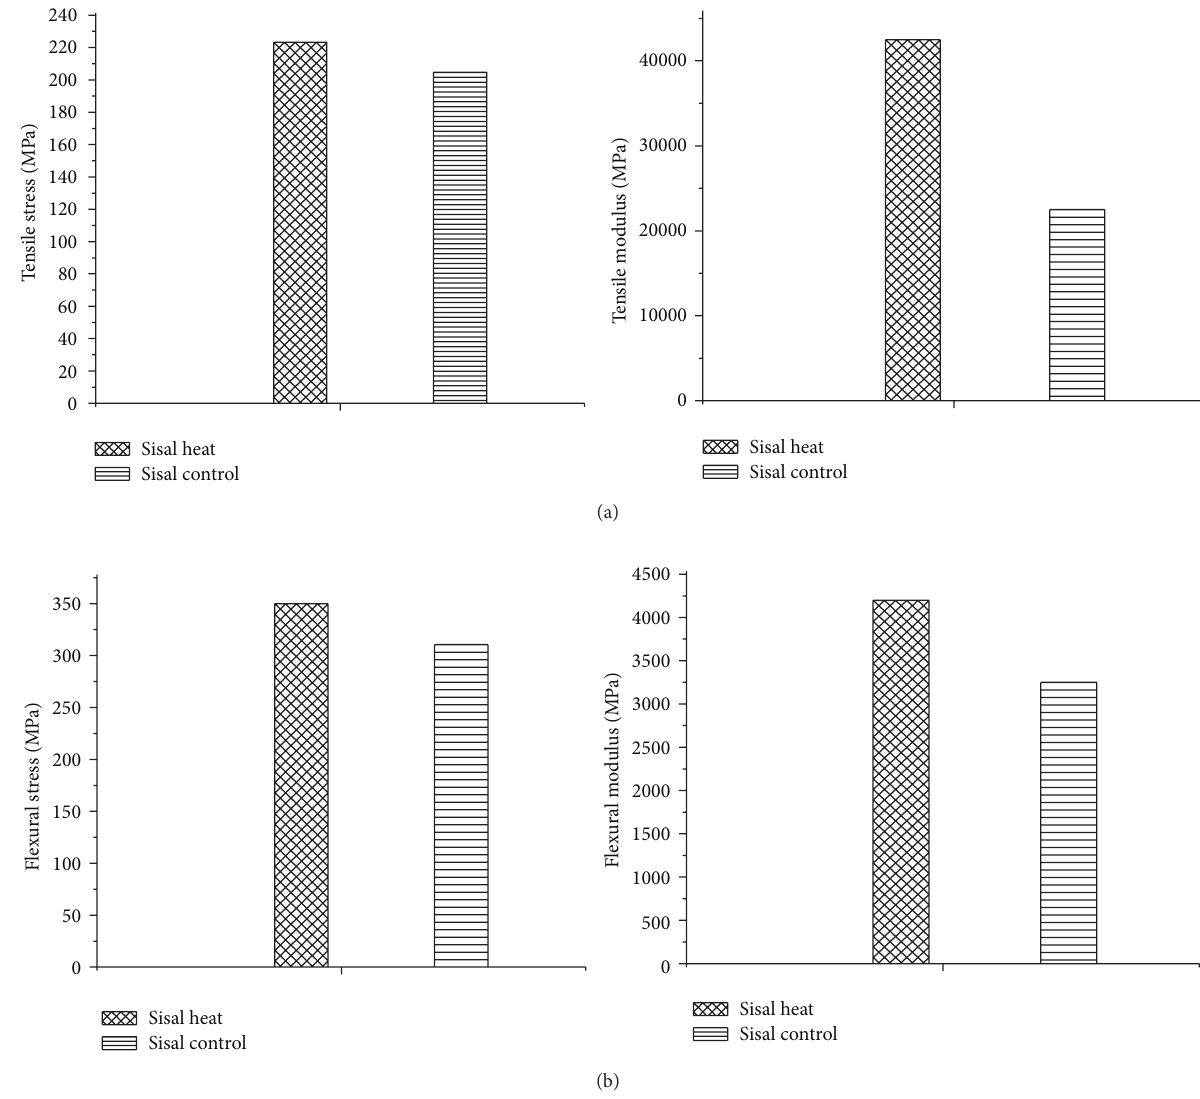
Figure 7: (a) Comparison of tensile behaviour of thermally conditioned and control woven sisal FRP composite, (b) Comparison of flexural behaviour of thermally conditioned and control woven sisal FRP